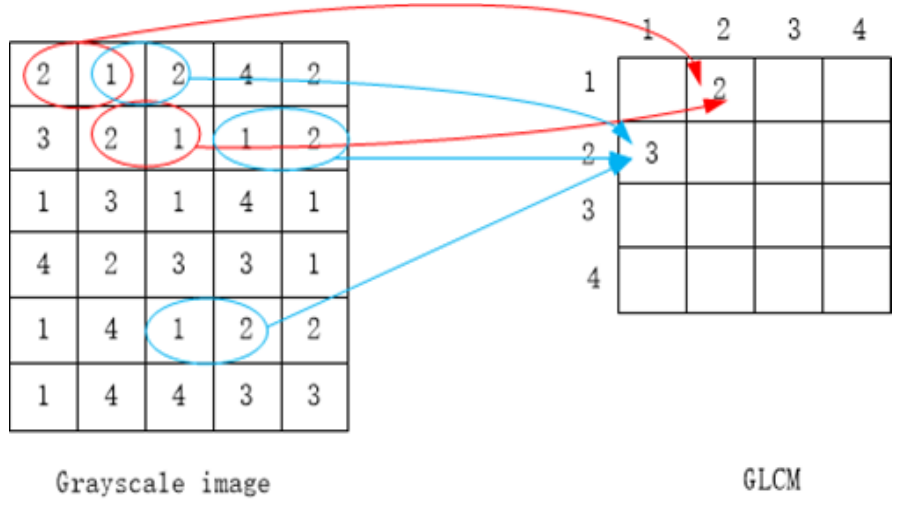
Figure 6. Acquisition of GLCM.